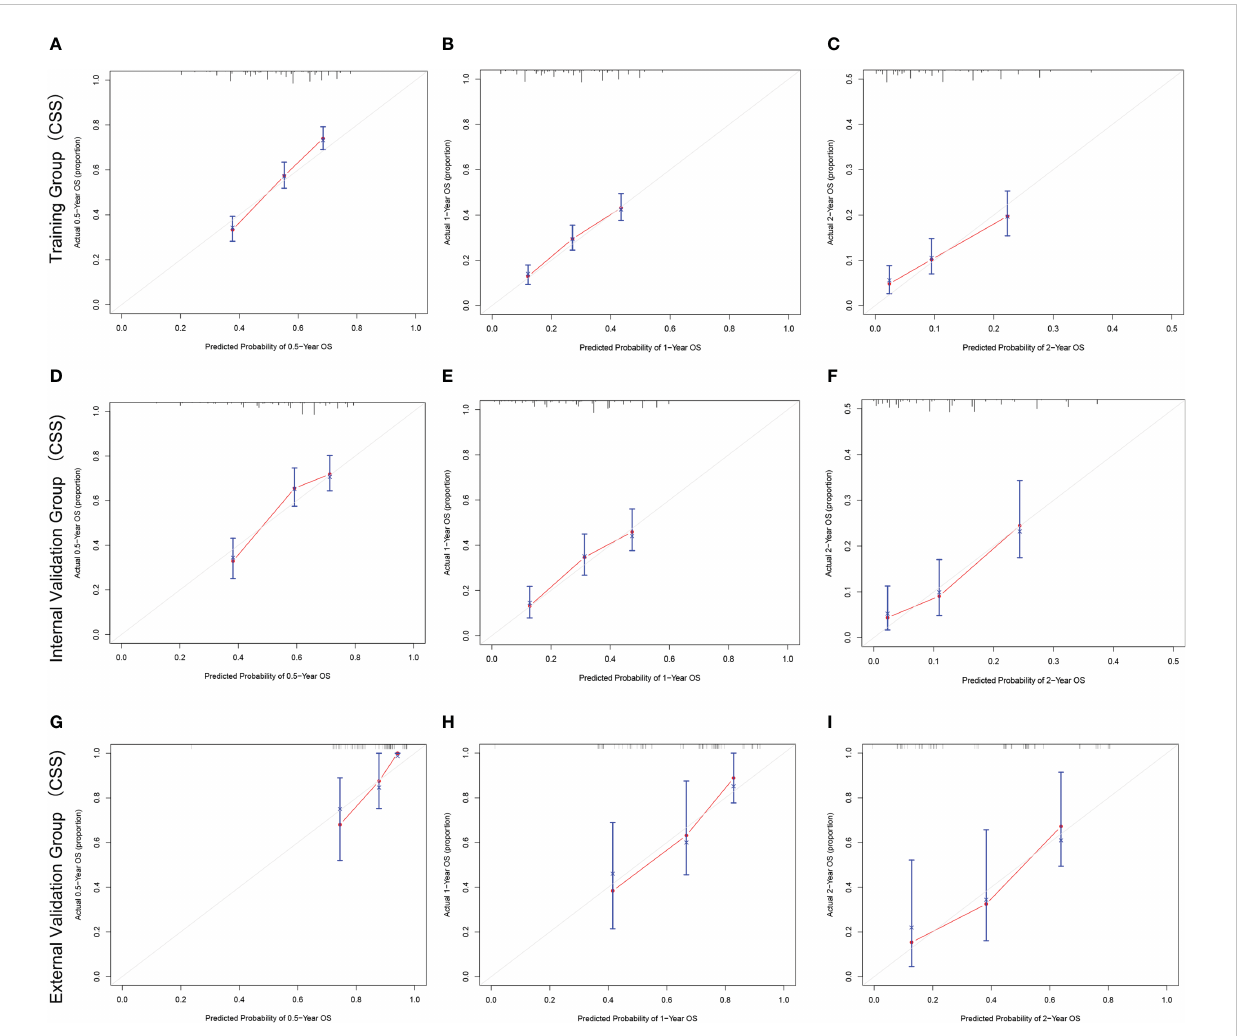
FIGURE 5 The calibration curves for predicting CSS at (A) 0.5-year and (B) 1-year and (C) 2-year in the training cohort, and at (D) 0.5-year (E) 1-year and (F) 2- year in the internal validation cohort, and at (G) 0.5-year (H) 1-year and (I) 2-year in the external validation